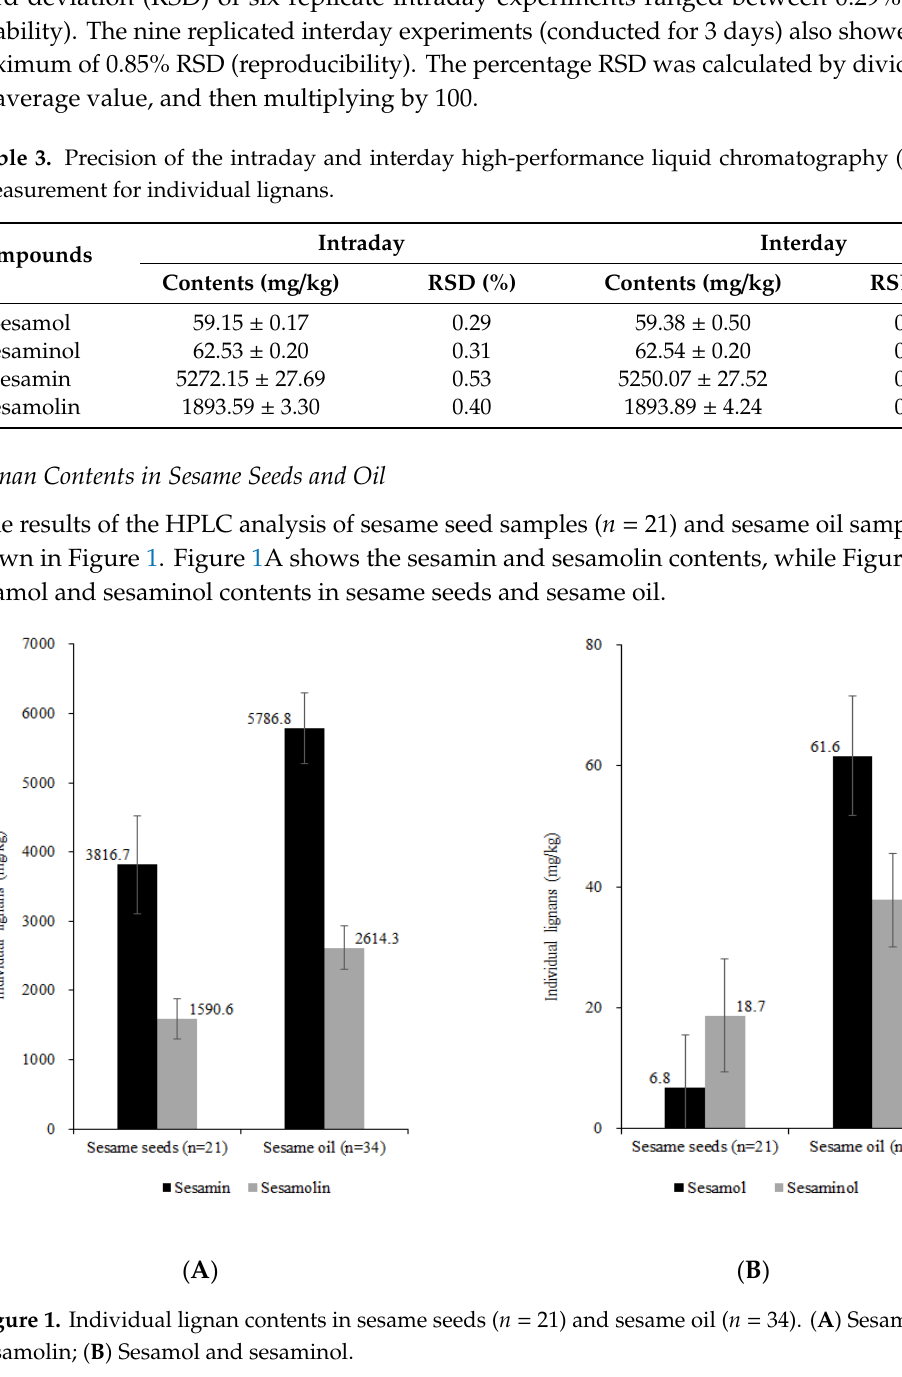
Table 4. Pearson correlation between compounds of sesame seeds and oil. Type